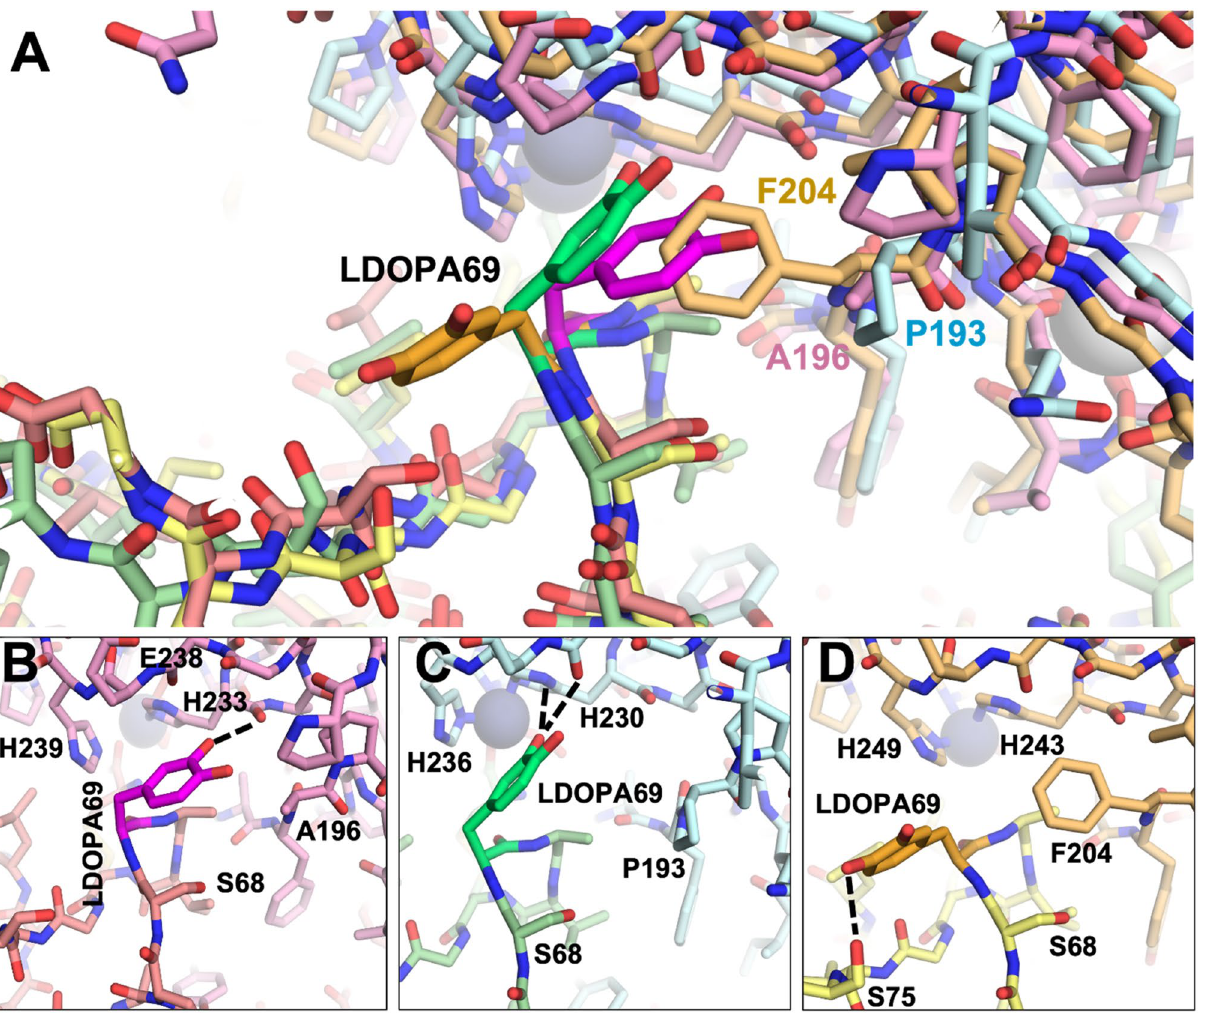
Figure 8. Structural comparison of MMP/N-TIMP2-S69DOPA complexes. ( A ) Superposition of modeled complexes of N-TIMP2-S69DOPA bound to each MMP are shown, with MMP-2/N-TIMP2-S69DOPA in pink/ salmon; MMP-9/N-TIMP2-S69DOPA in pale cyan/pale green; MMP-14/N-TIMP2-S69DOPA in yellow orange/ pale yellow. The MMP catalytic Zn 2+ is shown as a gray sphere. ( B – D ) The local environment surrounding L-DOPA is shown for a complex with MMP-2 ( B ), MMP-9 ( C ), or MMP-14 ( D ). L-DOPA is represented in magenta, lime, or orange, respectively, with potential H-bonds indicated by black dashed lines. L-DOPA is predicted to interact more closely with MMP-2 and MMP-9, whereas steric clash with Phe204 favors an alternative L-DOPA rotamer that does not interact with N-TIMP2 positions in TIMP/MMP interactions. Nevertheless, the findings that the inhibitory activity towards MMP-14 CAT was significantly impaired for all N-TIMP2-DOPA and N-TIMP2-HqAla variants, but was retained for MMP-2 ACT and MMP-9 CAT for most variants, emphasize the potential of these positions to alter N-TIMP2 selectivity towards different MMPs. An examination of the different substitution positions within N-TIMP-2 provides explanations for our find- ings. Position Ser2 of N-TIMP2, which is located in the N-terminal segment (residues Cys1-Pro5), is involved in the direct interaction between N-TIMP2 and the MMP catalytic pocket 13 and would therefore not be tolerant to mutation to a bulkier residue, as we observed for the substitutions with either L-DOPA or HqAla and as was previously shown for other substitutions, such as S2E 38 and S2D 39 , at this position. Our results are thus in line with previous findings, as Ser2 substitutions with both NCAAs led to significantly decreased affinities towards all tested MMPs, with a K i fold > 13, except for the retention of MMP-9 CAT inhibition by N-TIMP2-S2DOPA. Notably, N-TIMP2-S2HqAla showed a decrease of > 2 orders of magnitude in affinity towards all three MMPs, suggesting that the bulky side chain of HqAla, compared to Ser, interferes with MMP binding, probably due to steric hindrance. Position Y36 of N-TIMP2 is located on the tip of the AB loop (residues D30-K41) and interacts with MMP-14 at a site that is distant from the catalytic pocket 40,41 . It was previously found that different mutations (Y36F, Y36G and Y36W) led to decreased affinities towards MMP-14, exhibiting significant higher inhibition constants ( K i -fold